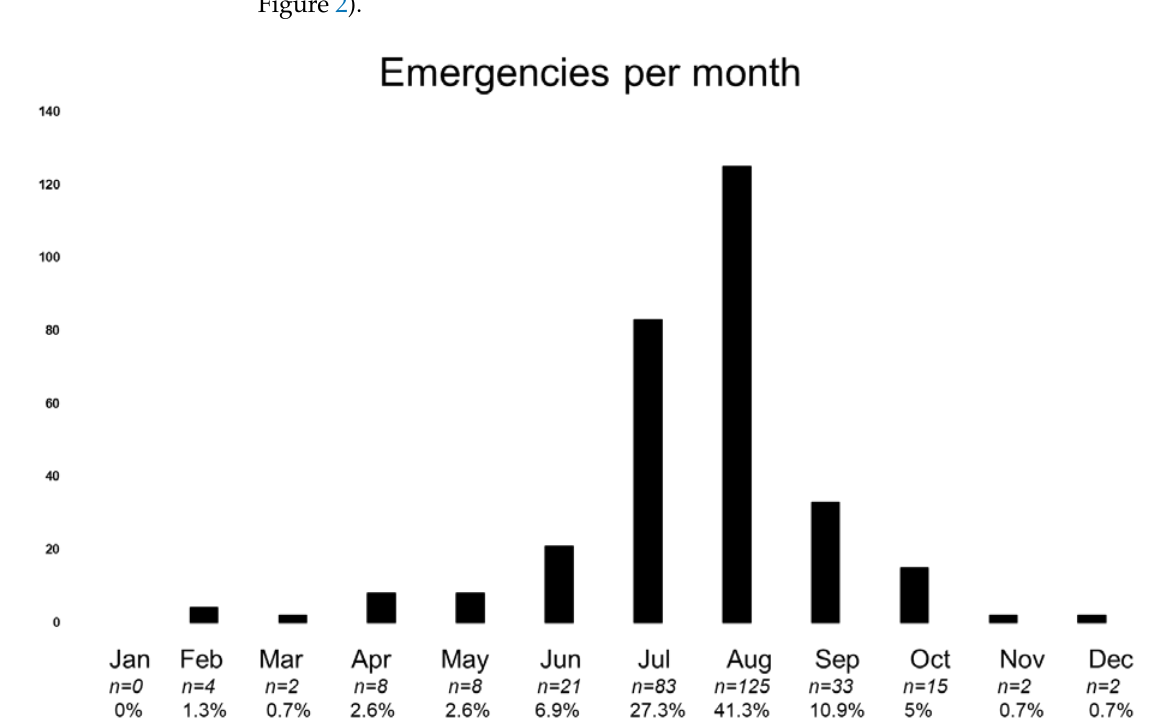
Figure 2. Most fatal events were in the summer months of July and